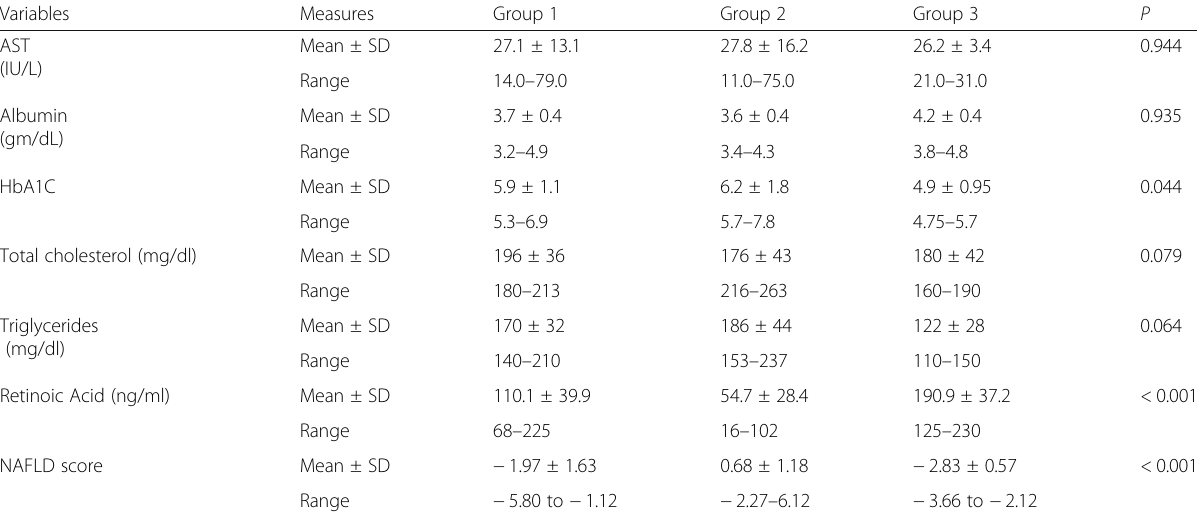
Table 2 AST, albumin, HbA1C, total cholesterol, and triglycerides among the studied groups